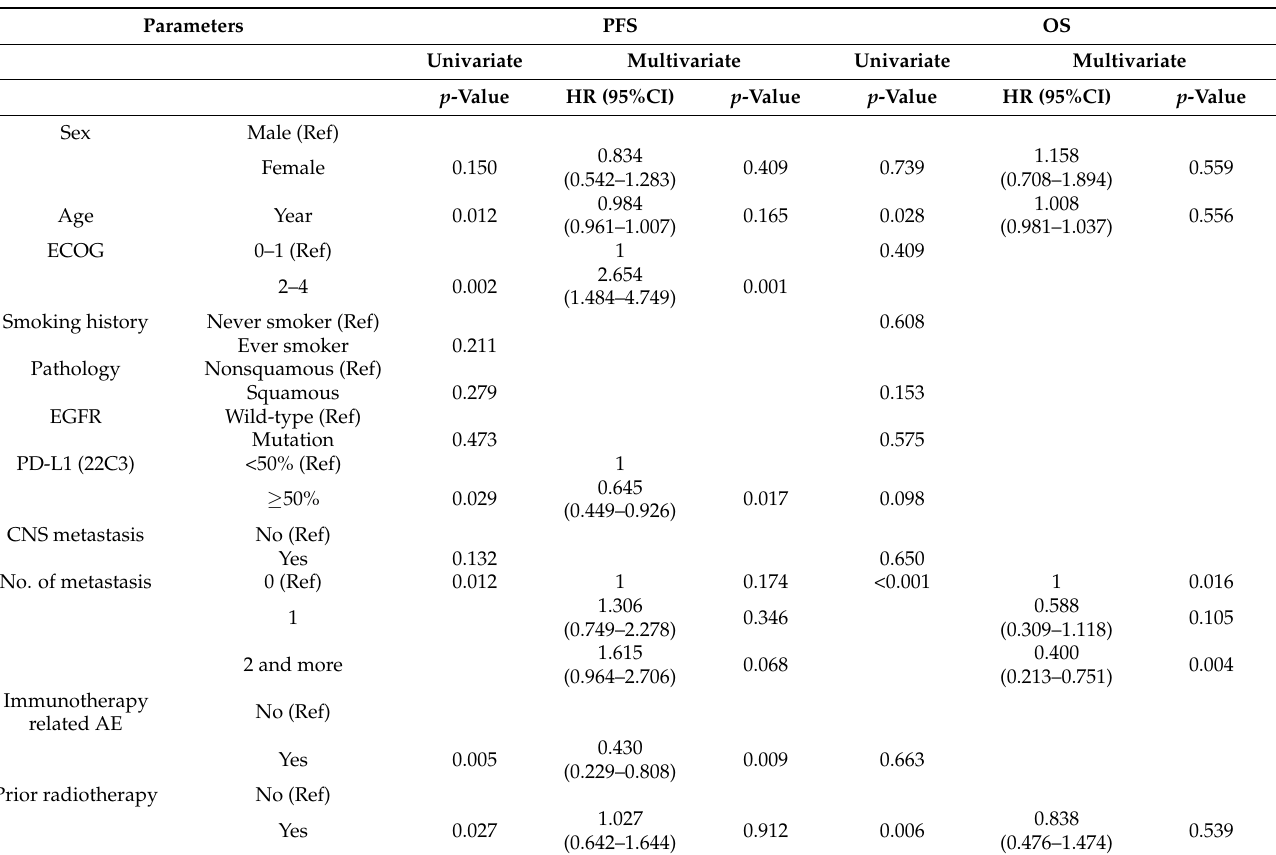
Table 2. Evaluation of association of clinical parameters with PFS and